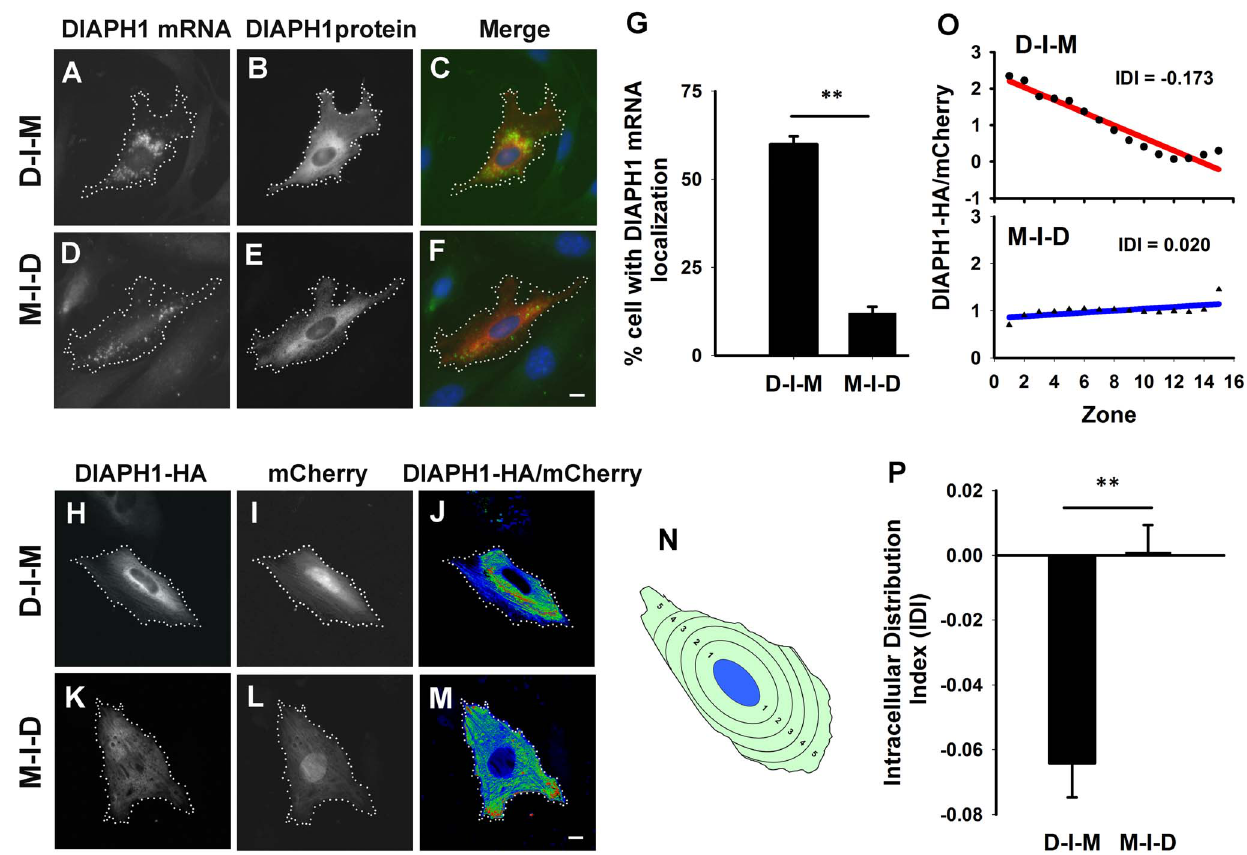
Figure 5. Localization of DIAPH1 mRNA correlates with DIAPH1 protein distribution. A–F . Representative transfected cells show localization of DIAPH1 mRNA and protein. A–B and D–E are gray scale images for the distribution of DIAPH1 mRNA and protein in NIH3T3 cells transfected with the construct of D-I-M ( A–C ) or M-I-D ( D–F ), respectively. Their merged images are shown in C or F . G . Quantitative results of DIAPH1 mRNA localization from analysis of 300 cells from three independent experiments for each expression construct. Error bars: sem. ** p , 0.01. H–P. Analysis of the relationship of localization of DIAPH1 mRNA and its protein distribution in NIH3T3 cells. H–I and K–L are gray scale images for distribution of DIAPH1-HA fusion protein and mCherry in NIH3T3 cells transfected with the construct of D-I-M ( H–I ) or M-I-D ( K–L ), respectively. Their merged images are shown in J or M . N . Illustration of a cell with 5 equal-area zones according to their relative distance to the nucleus border. Note that the shape of the zones are listed in the carton is simplified one and is likely vary within a cell (see Methods and Materials for details). O . Scatter plot graphs show two individual quantitative results of intracellular DIAPH1-HA fusion protein distribution in single NIH3T3 cells transfected with the construct of D-I-M and M-I-D, respectively. The red and blue color lines are linear regression for the ratio points of D-I-M or M-I-D transfected cells. P. A bar graph shows average IDI value for D-I-M or M-I-D transfected cells from analysis of 30 cells for each expression construct. Error bars: sem. ** p , 0.01.